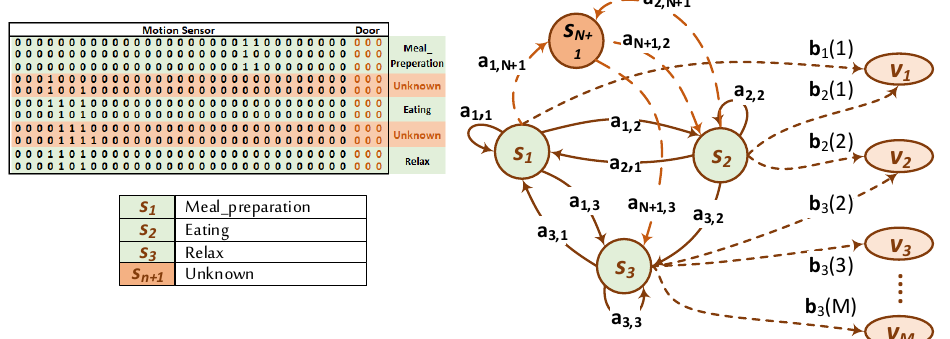
Figure 3. Paradigm #2: Annotation gaps are assigned a unique “Unknown” label under state s N + 1 .